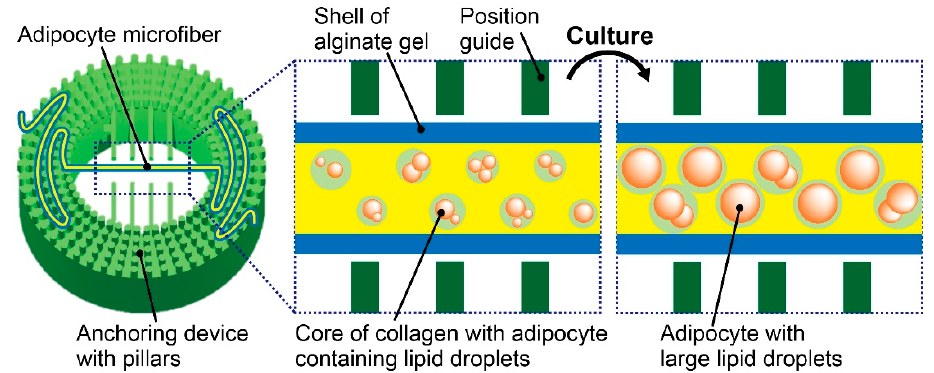
Figure 1. Conceptual illustration for immobilization of an adipocyte microfiber using the proposed anchoring device. By tangling the microfiber with pillars on the device manually, the microfiber becomes observable at the hollow section of the device for a long term without damaging the adipocytes.